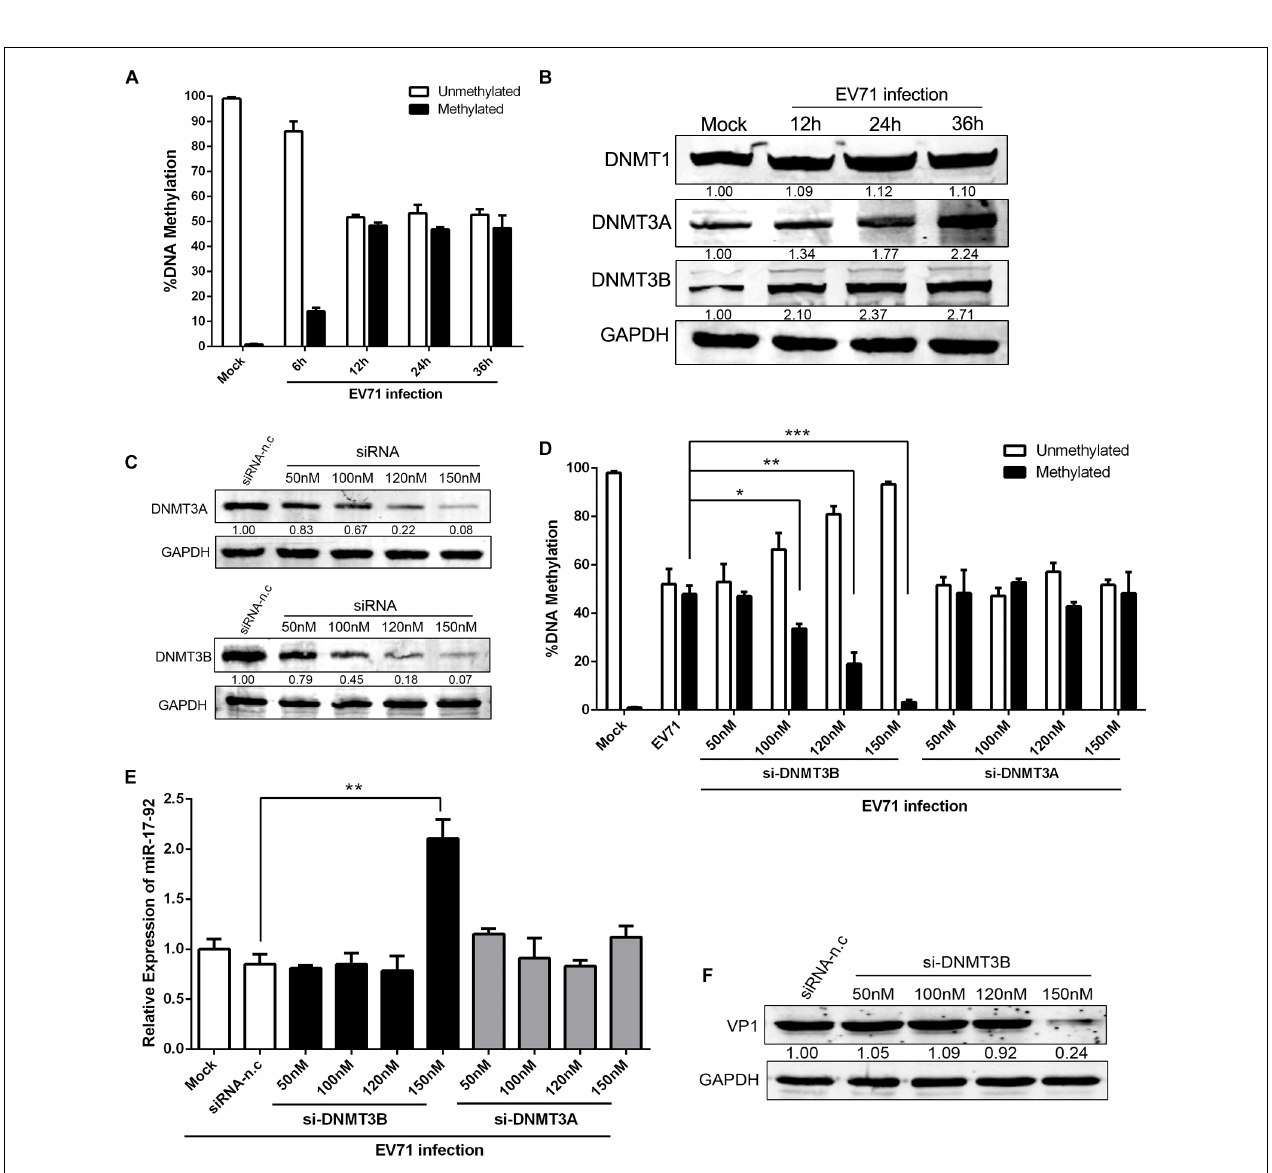
FIGURE 4 | Altered DNA methylation of the CpG island in the miR-17-92 cluster promoter in EV71 infection cells. (A) DNA was isolated from mock and EV71-infected cells ( n = 3). Data were presented as the average percent of unmethylated or methylated DNA of the miR-17-92 promoter. Statistical difference was determined by comparing the % unmethylated with % methylated for each group using QIAampDNA Mini Kit. (B) Western analysis of the expression levels of DNA methyltransferase (DNMT) enzymes 1, 3A, and 3B in EV71-infected HT-29 cells at the indicated time point. (C) HT-29 cells were transfected with DNMT3A- or 3B-specific siRNA for 48h and then detected by Western blot. The numbers represent the relative density of the band in comparison to the corresponding negative control normalized to GAPDH. Value of siRNA-n.c treatment is set at 1.00 (100%). (D) HT-29 cells were transfected with DNMT3A- or 3B-specific siRNA for 24 h and infected with EV71 at an MOI of 1. DNA was isolated and methylated DNA of the miR-17-92 promoter was determined by QIAampDNA Mini Kit. Shown is the percentage of DNA methylation, n = 4. (E) Pri-miR-17-92 cluster expression in cells transfected with si-DNMT3A- or 3B for 24 h and then infected with EV71 at an MOI of 1. (F) HT-29 cells was infected with EV71 (MOI = 1) prior to being transfected with si-DNMT3B for 24 h. EV71 VP1 protein expression level was determined via Western blot. Data were mean ± SEM of fold change and representative of at least three independent experiments ( ∗ P < 0.05, ∗∗ P < 0.01, ∗∗∗ P < 0.001).